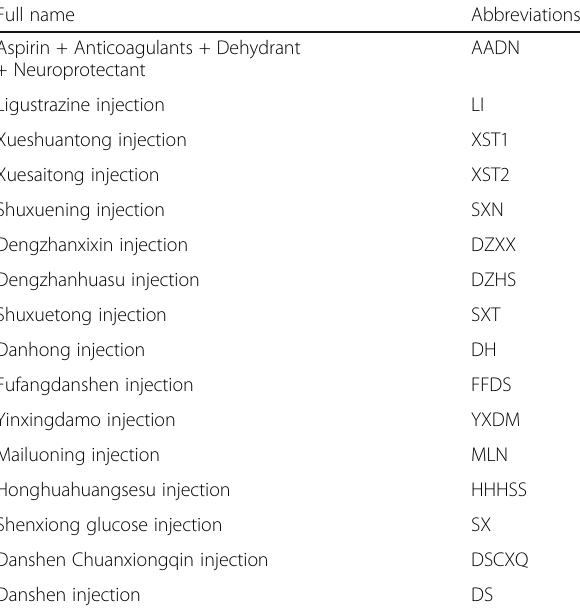
Table 1 Treatment